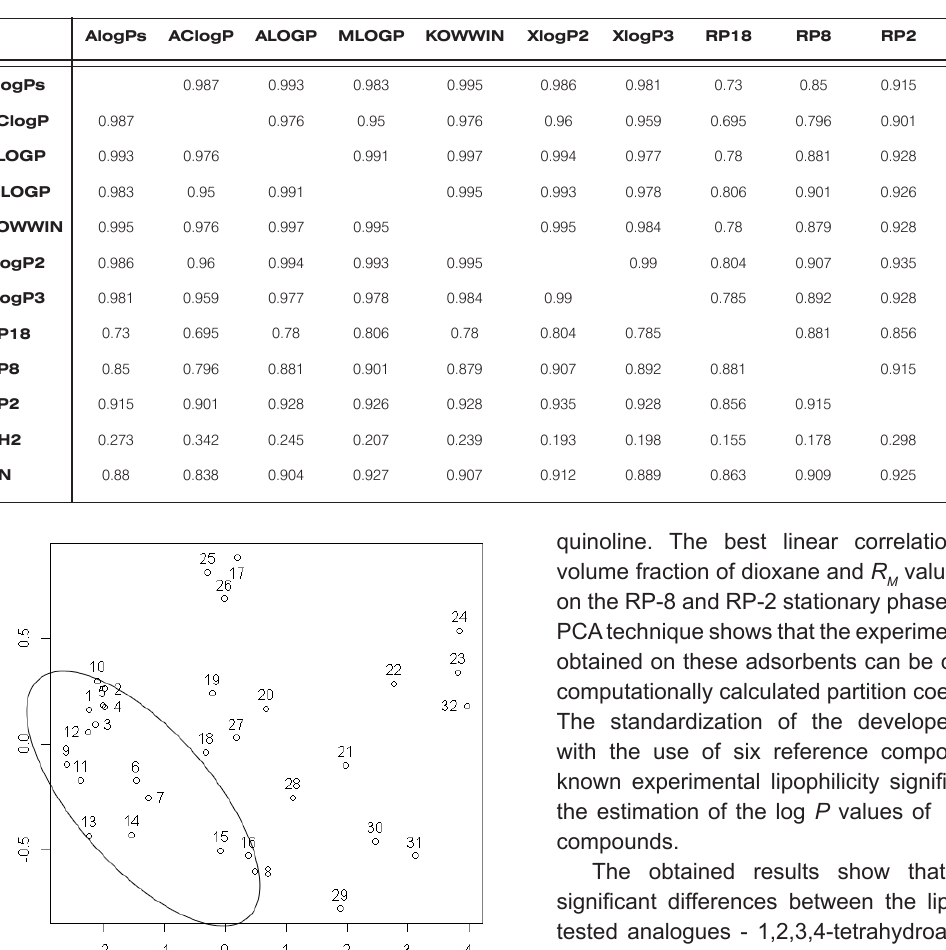
Table 5. Correlation matrix of experimental and computational lipophilicities of all investigated